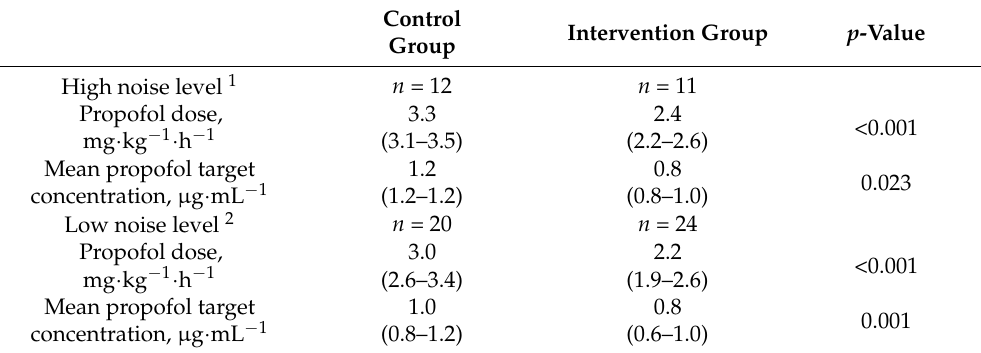
Table 4. Intraoperative propofol dose and mean propofol target concentration among surgeries with high noise or low noise